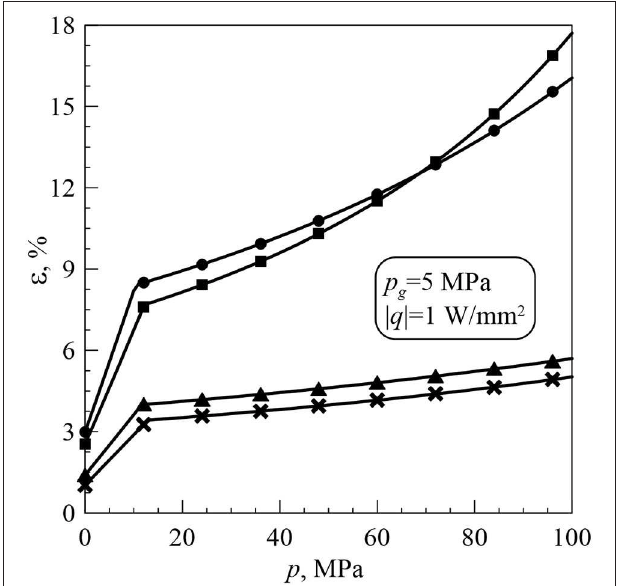
FIGURE 6 | The thermal rectification index ε vs. the applied pressure p .